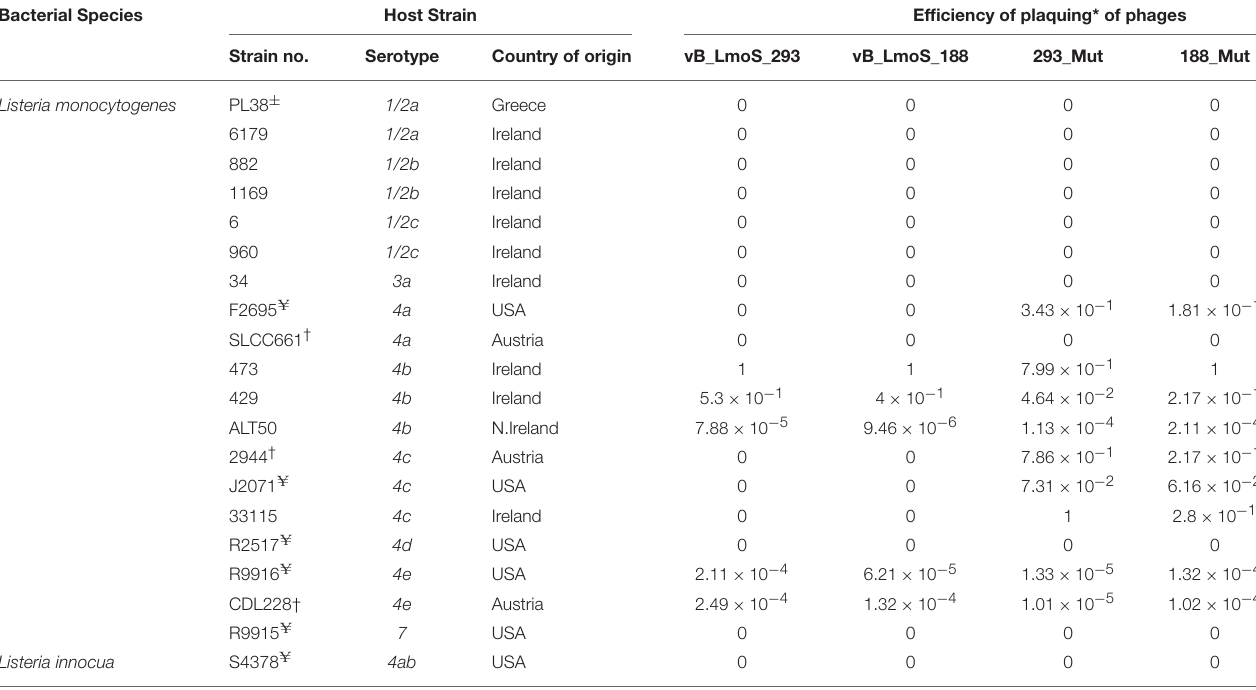
TABLE 1 | Host range analysis of phages vB_LmoS_188, vB_LmoS_293 and the two phage mutants 293_Mut and 188_Mut generated in this study. Bacterial Species Host Strain